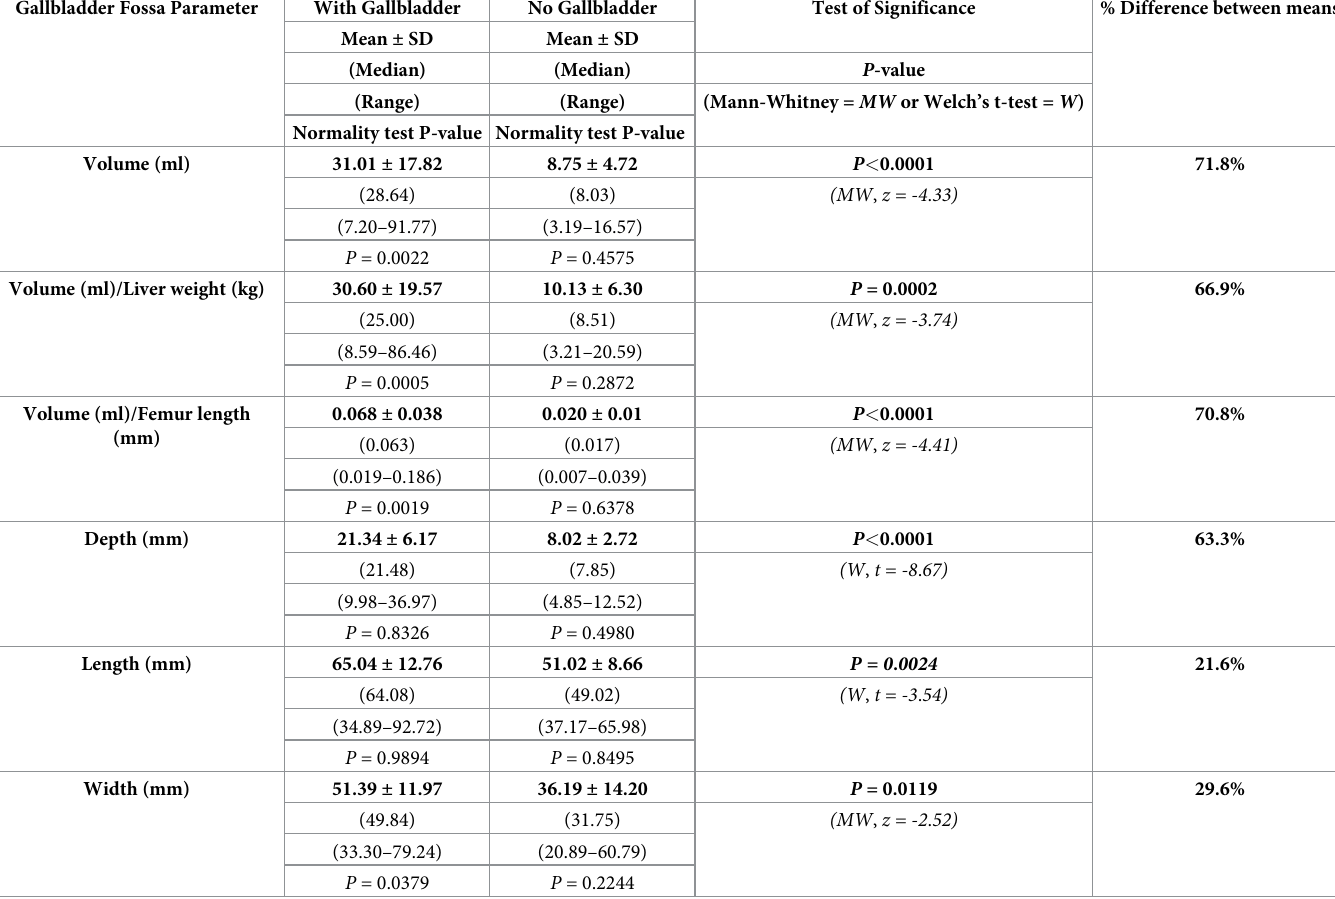
Table 1. Comparison of gallbladder fossa parameters in livers from cadavers with and without gallbladders. Gallbladder Fossa Parameter With